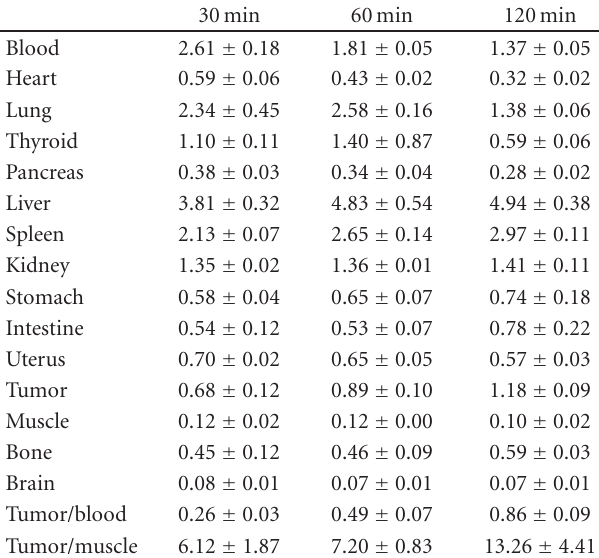
Table 1: Biodistribution of 68 Ga-GP in breast tumor-bearing Rats. % of injected dose per gram of tissue weight ( n = 3/time,